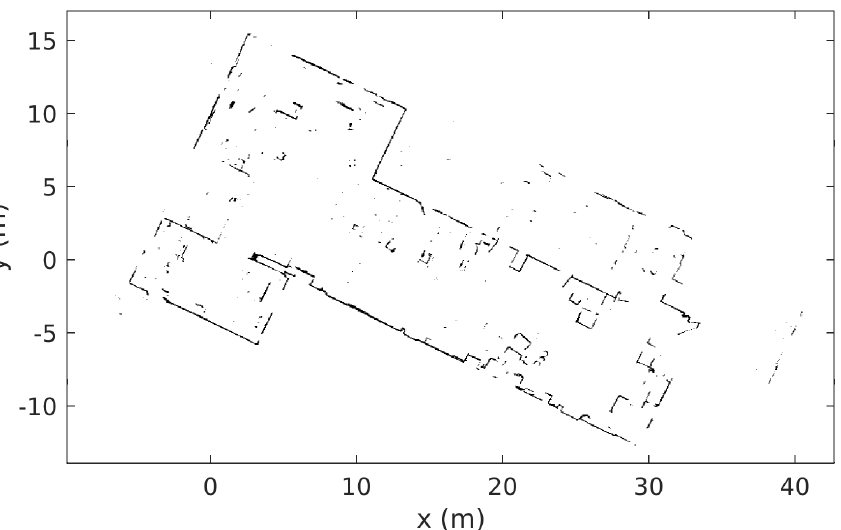
Figure 8. The map generated by the robot and used for localization, navigation, and